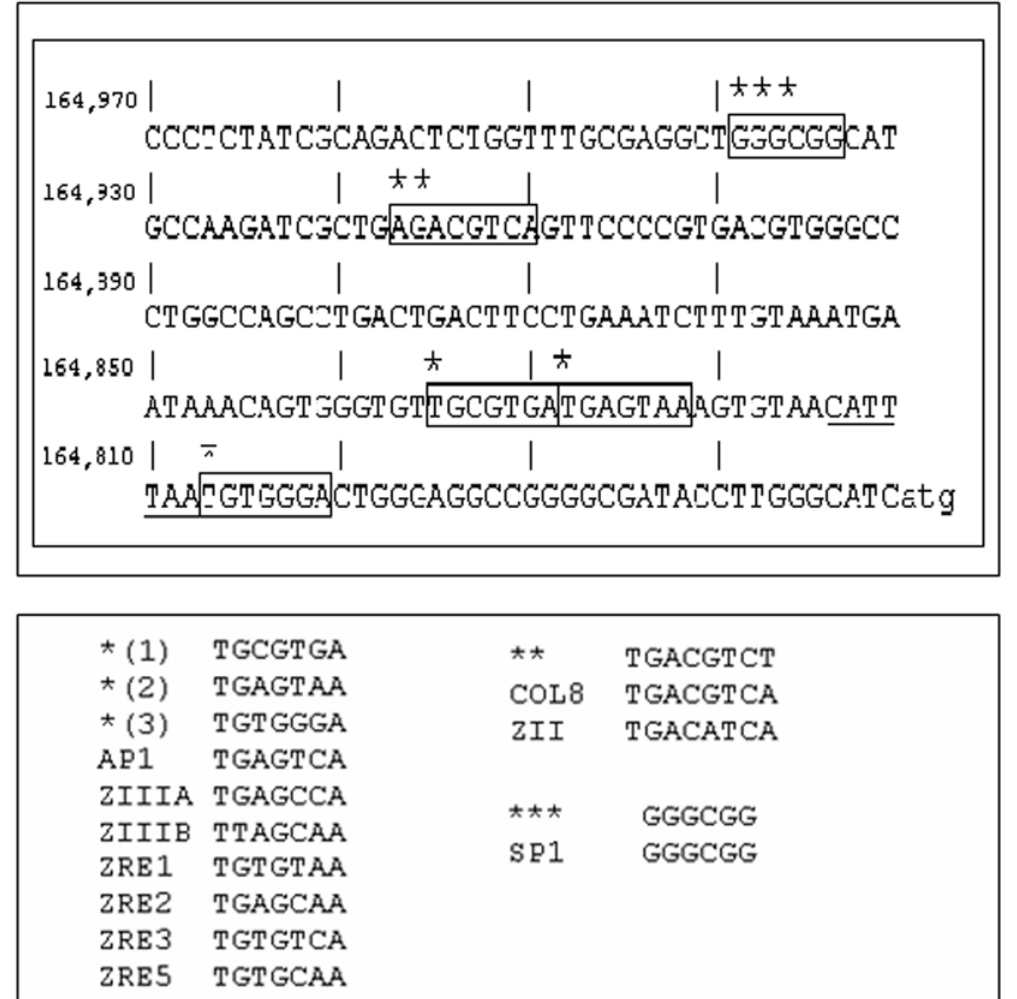
Figure 5. Shared somatic regulation between the EBV DBP BALF-2 protein gene and RAG. As shown, a 200 NT 5 9 region immediately adjacent to EBV BALF-2 ORF AUG start codon contains putative regulatory sequences for BZLF-1/AP-1 (denoted with a single asterisk), CREB (denoted with a double asterisk**), and SP1 (denoted with a triple asterisk***). These putative regulatory sequences are enclosed in boxes in the figure and include sequences recognized by the EBV encoded BZLF-1 regulatory protein (also termed ZEBRA protein). BZLF-1 sites also are also functional as sites for the endogenous regulatory factor AP-1 as discussed in the text. BZLF-1 regulated sites from other EBV genes ZIIIA, B, and ZRE1,2,3,5 are shown in comparison to a consensus AP-1 site in the lower portion of the figure. Similarly, in the lower portion of the figure the putative binding site for CREB is shown in the BALF-2 minimal promoter in comparison to Col8, a cAMP response element shown to bind CREB1 cAMP site binding protein with high affinity and ZII, a site in the BZLF-1 promoter shown experimentally to respond to cAMP. Also in the lower portion of the figure, a site in the BALF-2 minimal promoter matching the Sp1 transcription factor consensus is shown, similar but not identical to Sp1 binding sites confirmed to exist in the EBV terminal repeats (Figure